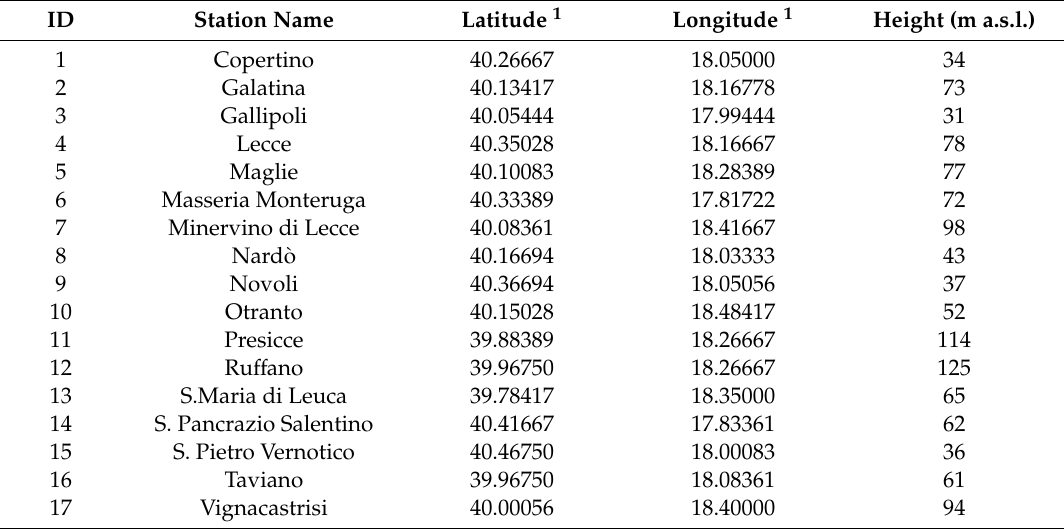
Table 3. Rain gauges